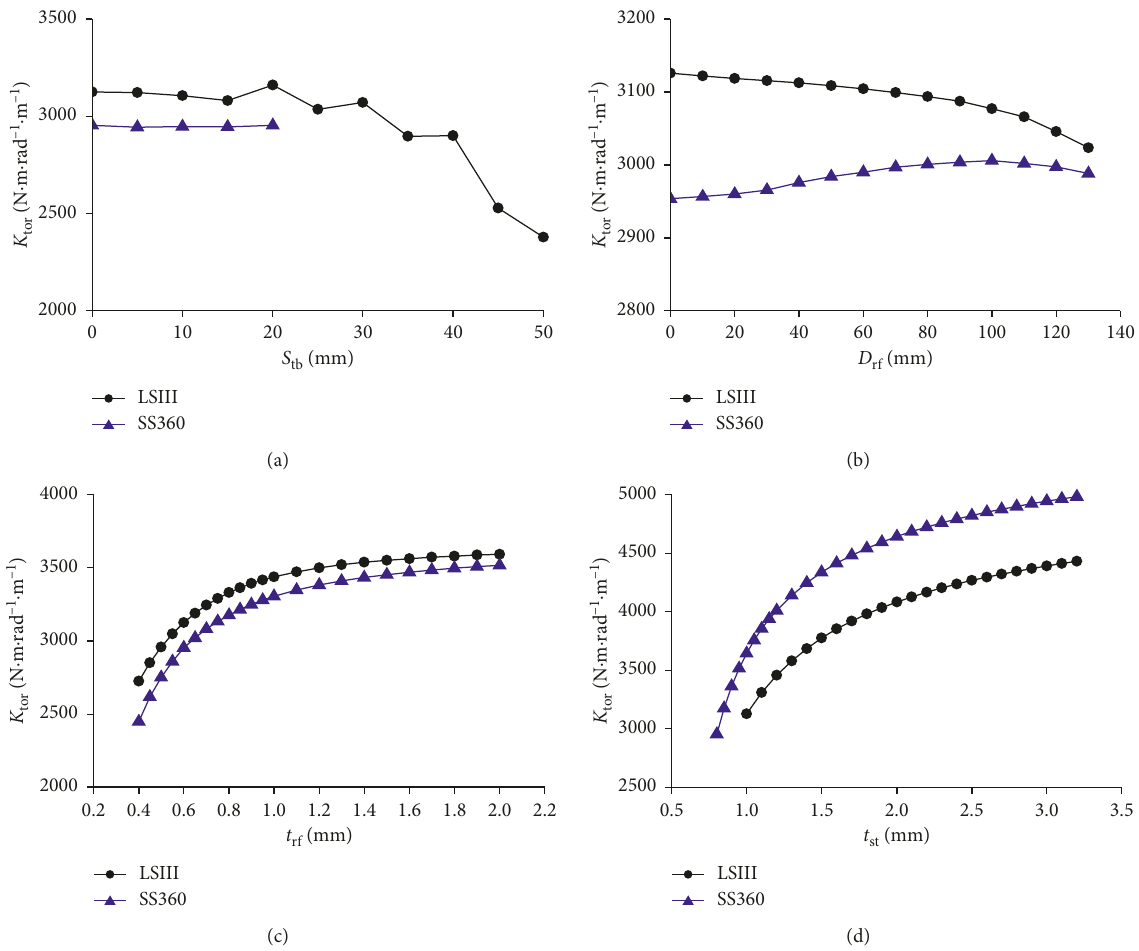
Figure 8: Correlation between the rotational restrain rigidity K K tor and t rf , and (d) between K tor and t st